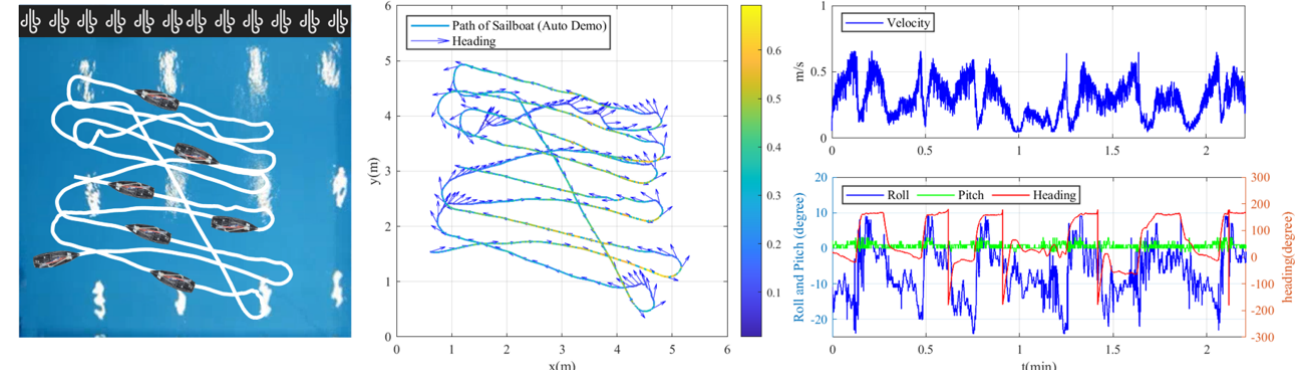
Figure 12. Automatic control in remote teaching mode. The left picture shows the path and wind direction in real test environment. The middle figure is the path of the sailboat with heading arrow and speed color-bar. The right figures are velocity and attitude versus time.